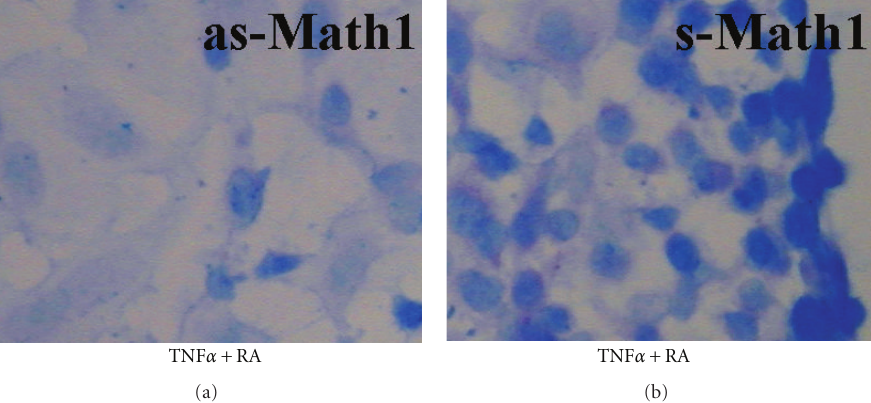
Figure 9: Math1 plays an important role in the di ff erentiation of mucous-like cells. (a) With Math1 being knocked down by antisense-Math1 (as-Math1), AB-PAS-positive cells are obviously reduced in cultured mouse middle ear epithelial cells. (b) With Math1 being upregulated by sense-Math1 (s-Math1), AB-PAS-positive cells are remarkably increased. RA, retinoid acid; TNF α , tumor necrotic factor